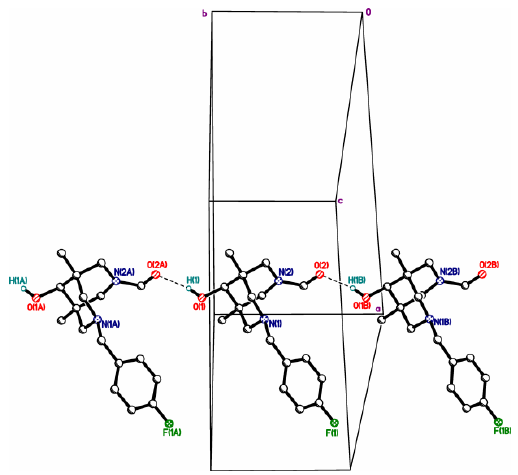
Figure 2. Hydrogen-bonded chains in structure 2c .